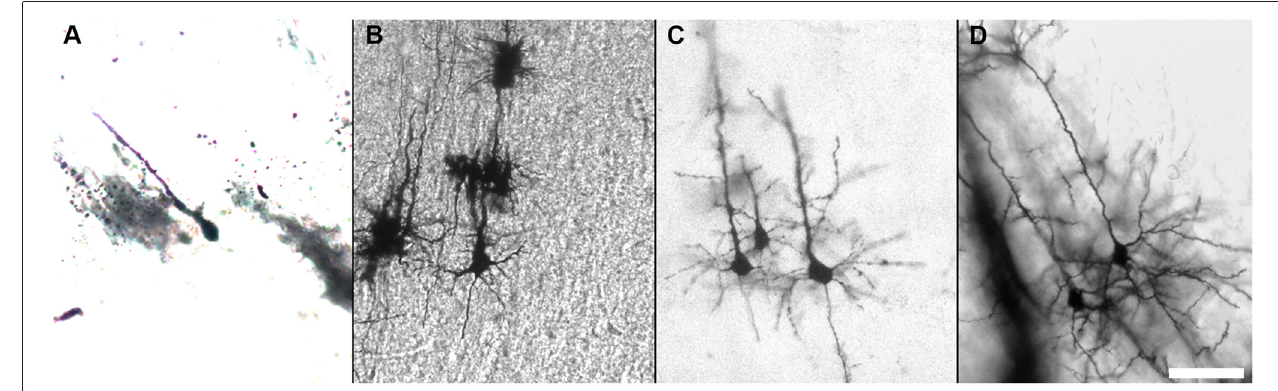
FIGURE 6 | Golgi-Cox staining of the developing mouse brain . Impregnation of neurons of the developing mouse brain can be improved after brief fixation with 4% PFA as shown for P0 (A) , P5 (B) , P7 (C) , and P10 (D) . (Golgi staining, DIC images, scale bar 50 µ m).